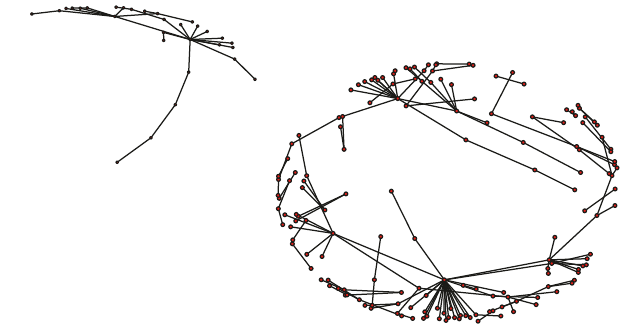
Figure 7: Random node attack.